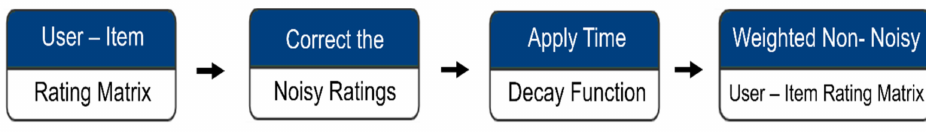
Figure 1. Data preprocessing